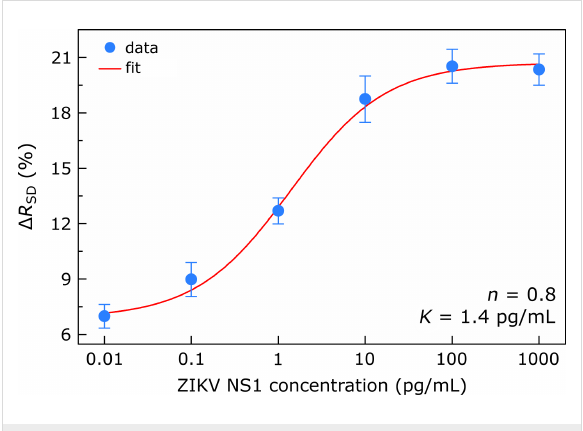
Figure 5: Calibration curve for ZIKV NS1 protein detection. Percent- age change in graphene resistance ( Δ R SD ) at V G = 0.2 V as a function of the ZIKV NS1 protein concentration. For each specific dilution, the blue filled circle represents the mean percentage increment in graphene resistance accounted for seven different devices; the error bars show the standard error of the measurements. The red line is a Hill–Langmuir curve fitted to the experimental data (R 2 =